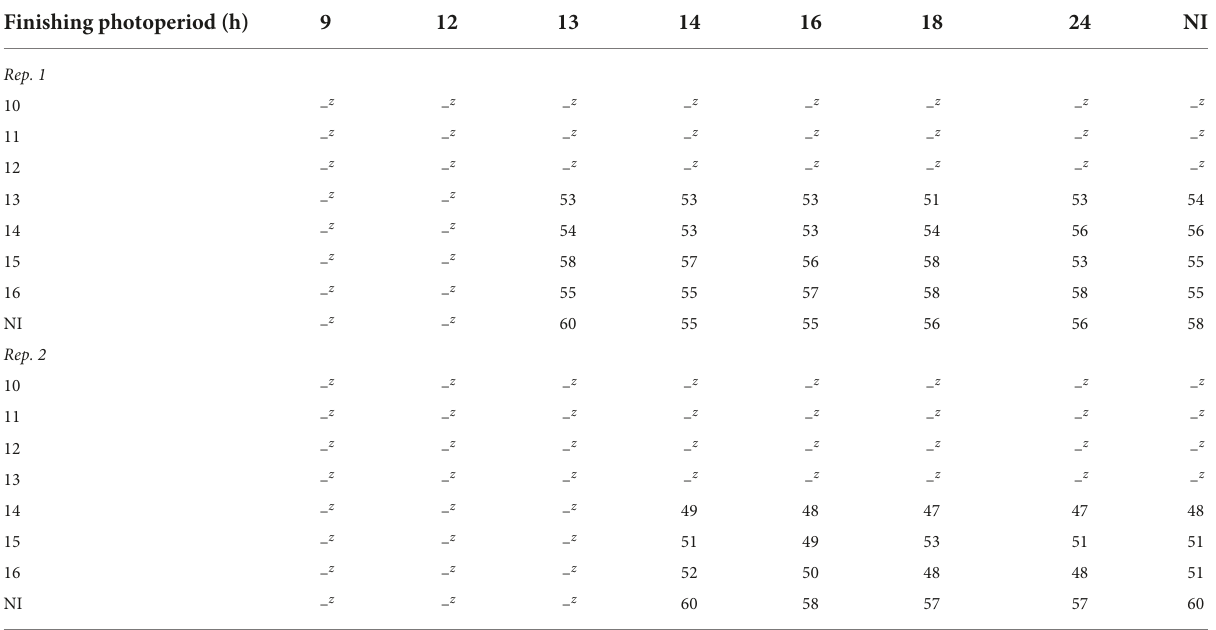
TABLE 5 Effects of young-plant photoperiod (9, 12, 13, 14, 16, 18, and 24 h, or a 4-h NI) and finishing photoperiod (10, 11, 12, 13, 14, 15, and 16 h, or a 4-h NI) on time to harvest (d) from the date of transplant of witchgrass ‘Frosted Explosion’ ( Panicum capillare ) grown under a moderate DLI of